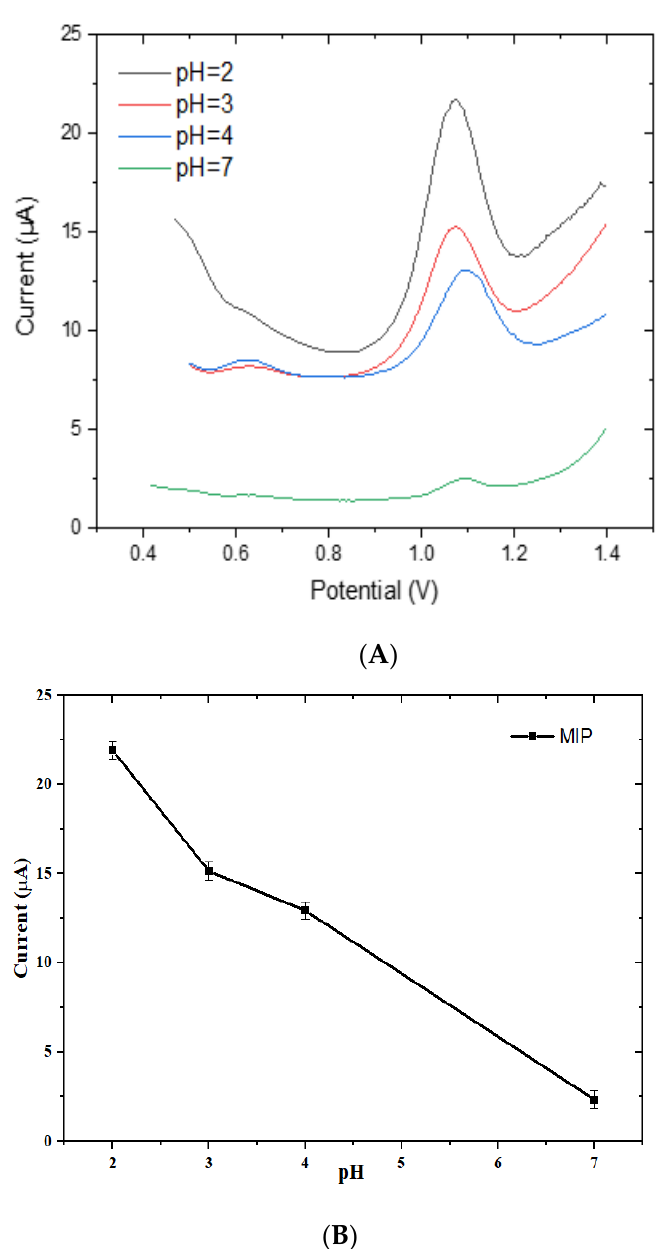
Figure 11. ( A ) Variation of the DPV signal of SDZ for different values of pH. ( B ) Variation of the DPV signal of SDZ as a function of pH values.